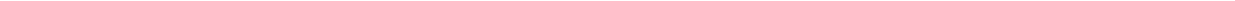
table Rho-kinase using the LOVTRAP optogenetic approach to enable local activation of the kinase 30 . In the dark, Rho-kinase CAT-Zdk1 was sequestered in mitochondria. During blue-light Fig. 3 Polarized activation of RhoA/Rho-kinase in the cell body was required for minor neurite retraction. a Spatio-temporal activation of RhoA in neurons. PBS ( top ) or NT-3 ( bottom ) was locally applied to the axon terminal ( arrow ) of a neuron expressing Raichu-RhoA-CR. The pseudocolored images represent the Raichu-RhoA-CR emission ratio. Arrowhead indicates the activation of RhoA at the cell body. Scale bar, 20 μ m. b Time course of changes in FRET ef fi ciency in the cell body. c NT-3-induced minor neurite retraction was abolished by RhoA/Rho-kinase signaling inhibitors. The axon was exposed to NT-3 in the presence of the indicated inhibitors, and minor neurite outgrowth was measured (DMSO (PBS) = 16, DMSO (NT-3) = 22, C3 = 23,Y-27632 = 28, Blebbistatin = 22 neurites from three independent experiments). d The mean amplitude of increases in FRET ef fi ciency for 2 min during local application were measured. The FRET ef fi ciency in the cell body was analyzed after treatment with vehicle (control) or the indicated inhibitors in the presence of NT-3 (DMSO (PBS) = 37, DMSO (NT-3) = 37, BAPTA = 37, STO-609 = 37, KN-93 = 37 neurons from three independent experiments). e Cartoon representation of the photoactivatable Rho-kinase (LOVTRAP-Rho-kinase). f Photoactivation of RhoA or Rho-kinase in the cell body induced minor neurite retraction. The cell body of a neuron coexpressing NTOM20-LOV2 with mCherry-Zdk1 (LOVTRAP-Cont), mCherry-Zdk1-RhoA Q63L (LOVTRAP-RhoA), mCherry-Rho-kinase CAT-Zdk1 (LOVTRAP-Rho-kinase), or mCherry-Rho-kinase CAT KD-Zdk1 (LOVTRAP-Rho-kinase KD) is illuminated in the 20- μ m square. Representative images of neurons by photoactivation for 60 min are shown. Yellow and white arrowheads indicate the retracting and resting minor neurites, respectively. g , h Time course of changes in the lengths of minor neurites g and the axon h from a single neuron expressing LOVTRAP-Cont, LOVTRAP-RhoA, LOVTRAP-Rho-kinase, or LOVTRAP-Rho-kinase KD (LOVTRAP-Cont = 40, LOVTRAP-RhoA = 23, LOVTRAP-Rho-kinase CAT = 44, LOVTRAP-Rho-kinase CAT KD = 36 neurites from fi ve independent experiments). i Photoactivation of RhoA or Rho-kinase in the axon induced axonal retraction. The distal part of the axon of a neuron expressing LOVTRAP-Cont, LOVTRAP-RhoA, LOVTRAP-Rho-kinase or LOVTRAP-Rho-kinase KD is illuminated (LOVTRAP-Cont = 8, LOVTRAP-RhoA = 9,LOVTRAP-Rho-kinase CAT = 9, LOVTRAP-Rho-kinase CAT KD = 9 neurons from three independent experiments). Error bars represent SEM. * P < 0.05 and ** P <